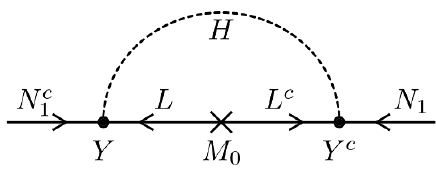
Figure 4 . Feynman diagram depicting one-loop radiative corrections to M 1 given in eq. (2.17). terms in eqs. (2.1) and (2.6) exhibit the